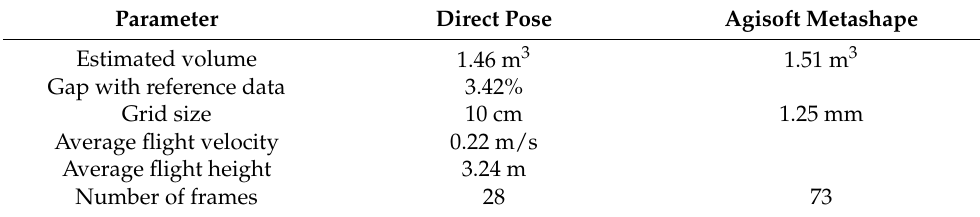
Figure 11. Micro-dump, orthomosaic obtained by fusion of 73 pictures acquired by a commercial drone. Quantitative data about the experiment are provided in Table 4. It arises that the gap between the photogrammetric estimate and the direct pose one is about 3.5%. In particular, the volume estimated through photogrammetry is 1.51 m 3 using a reconstruction grid of 1.25 mm. The result obtained from the proposed methodology is 1.46 m 3 using a grid of 10 cm. Table 4. Micro-dump experiment, quantitative data.